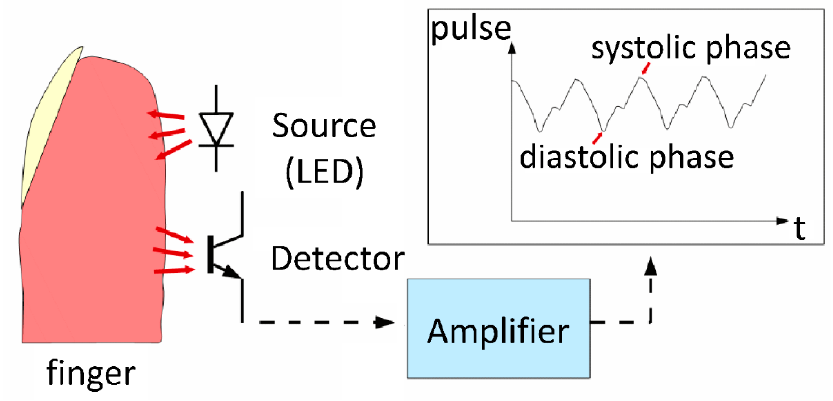
Figure 1. Diagram of engineered finger pulse recorder.